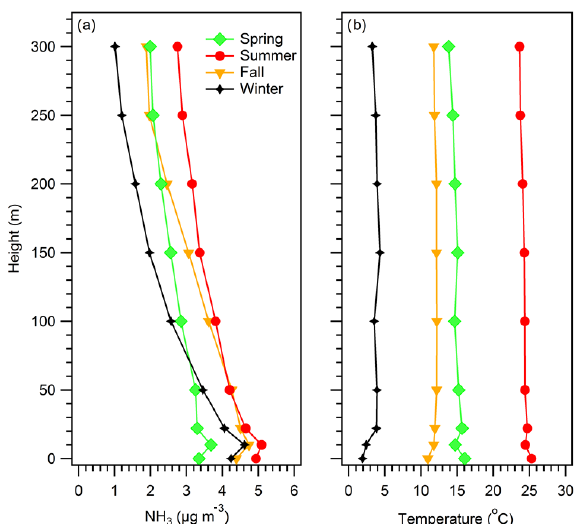
Figure 5. Comparison of seasonal average vertical profiles of (a) NH 3 concentration and (b) temperature measured at the BAO tower from 13 December 2011 to 9 January 2013.